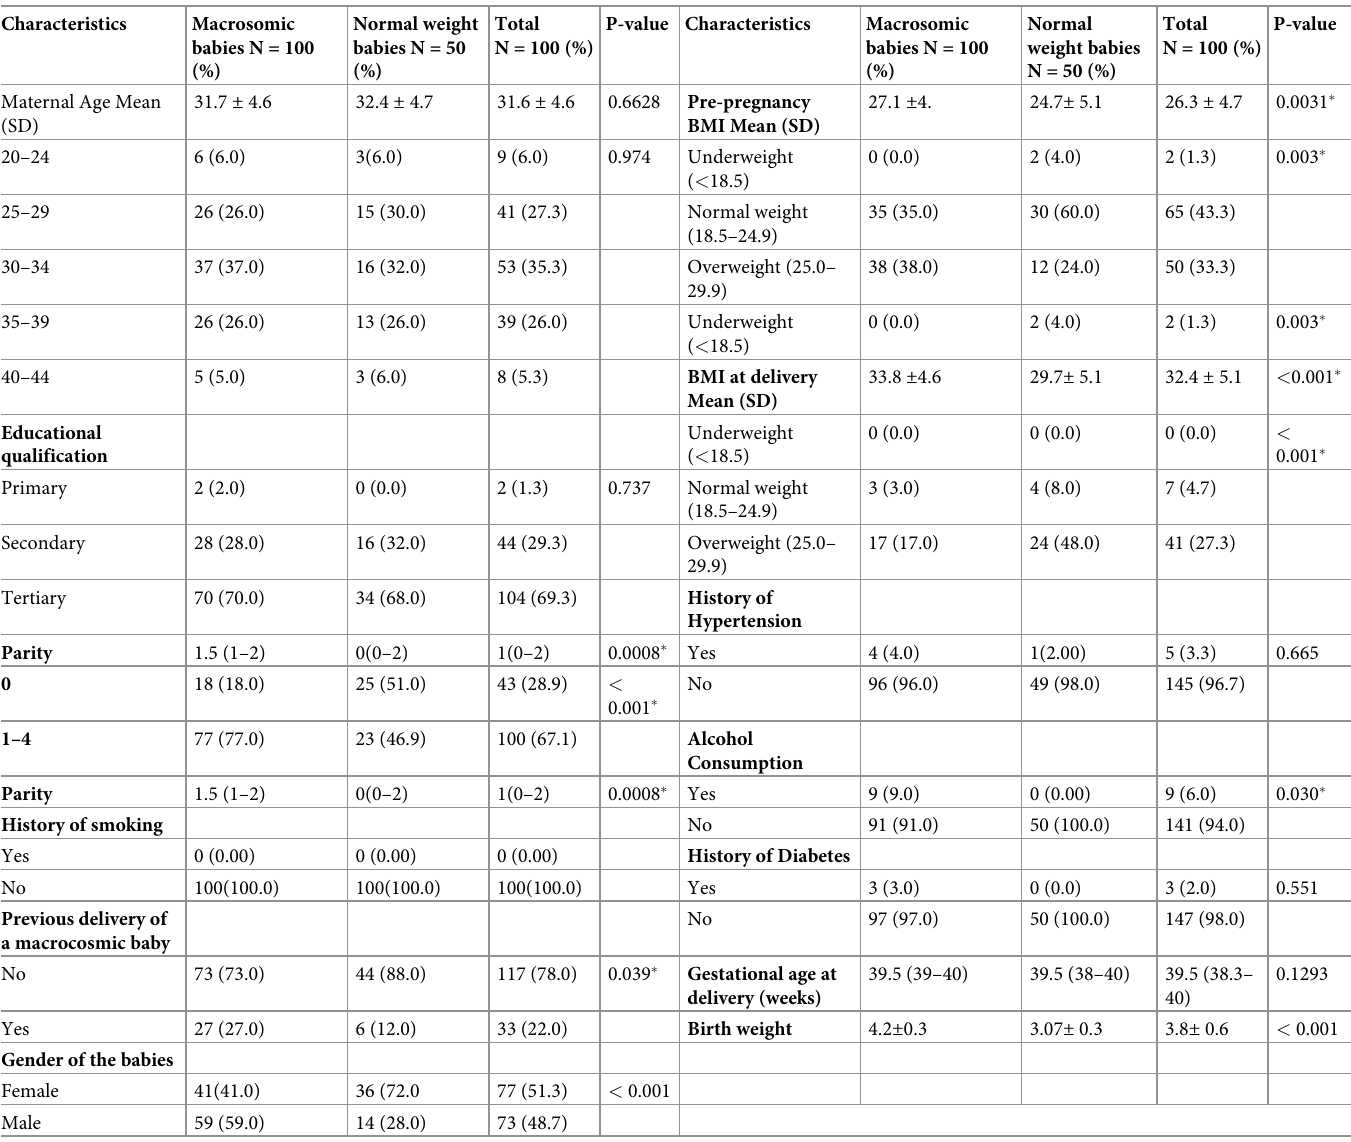
Table 1. Socio-demographic characteristics of the